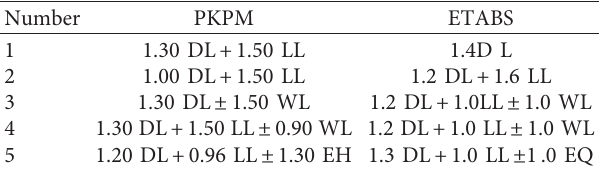
Table 3: Main load combination used in PKPM and ETABS.